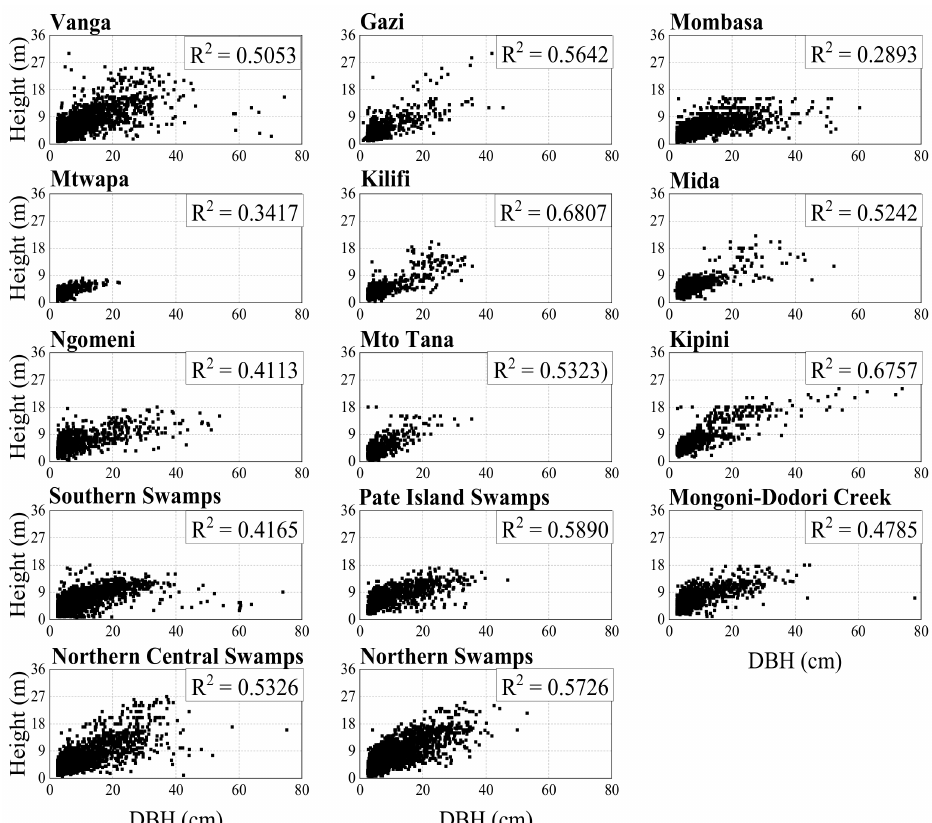
Figure 4. Height–diameter distribution of mangrove forests in the 14 sampled sites along the coast of Kenya. R2 is the coefficient of determination from regression